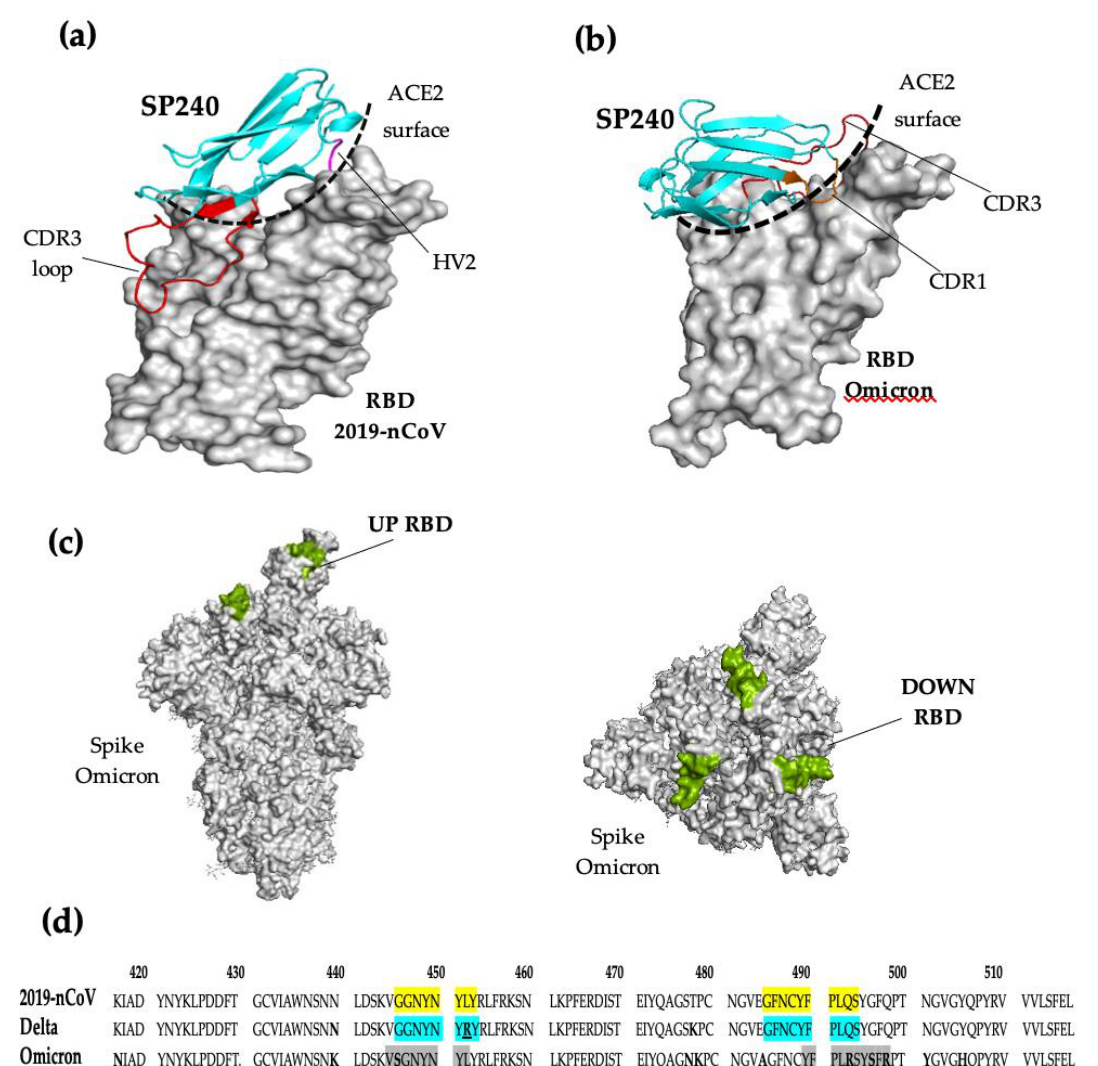
Figure 6. Structural analysis of Variable New Antigen Receptor (VNAR) SP240 coupled to SARS- CoV-2 variants. ( a ) VNAR SP240 coupled to the RBD of SARS-CoV-2 (2019-nCoV) and bound to the RBD of Omicron SARS-CoV-2 ( b ). In both interaction models, the CDR3 of the VNAR SP240 loop is shown in red, and the ACE2 binding interface in RBD is marked with dashes. ( c ) Surface view of the Omicron’s spike protein displaying the RBD in the “up” and “down” conformation. The binding sites of VNAR SP240 are indicated in green color. ( d ) Sequence alignments of the RBD from three SARS-CoV-2 variants. The mutated amino acids within the SARS-CoV-2 variants are underlined. The amino acids in the RBD involved in the interaction with VNAR SP240 are shown with colors: 2019-nCoV (yellow), Delta (blue), and Omicron (gray).